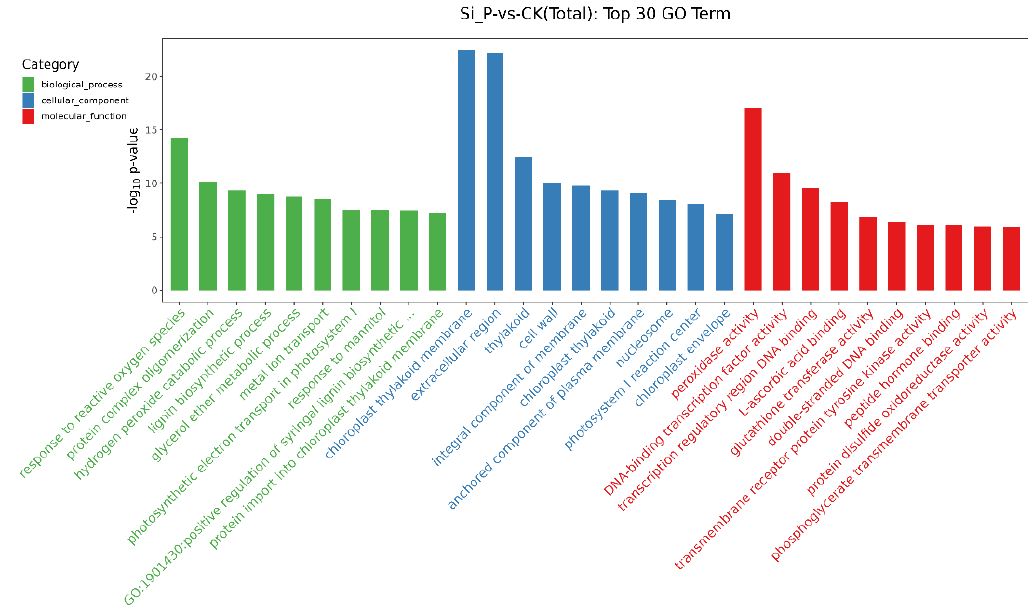
Figure 7. GO analysis of differentially expressed genes (DEGs) between CK and P. CK, no Pga inoculation; P, Pga inoculation.